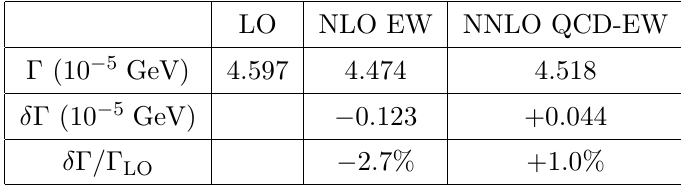
Table 1 . The partial decay widths at various orders in the α ( m Z ) scheme.